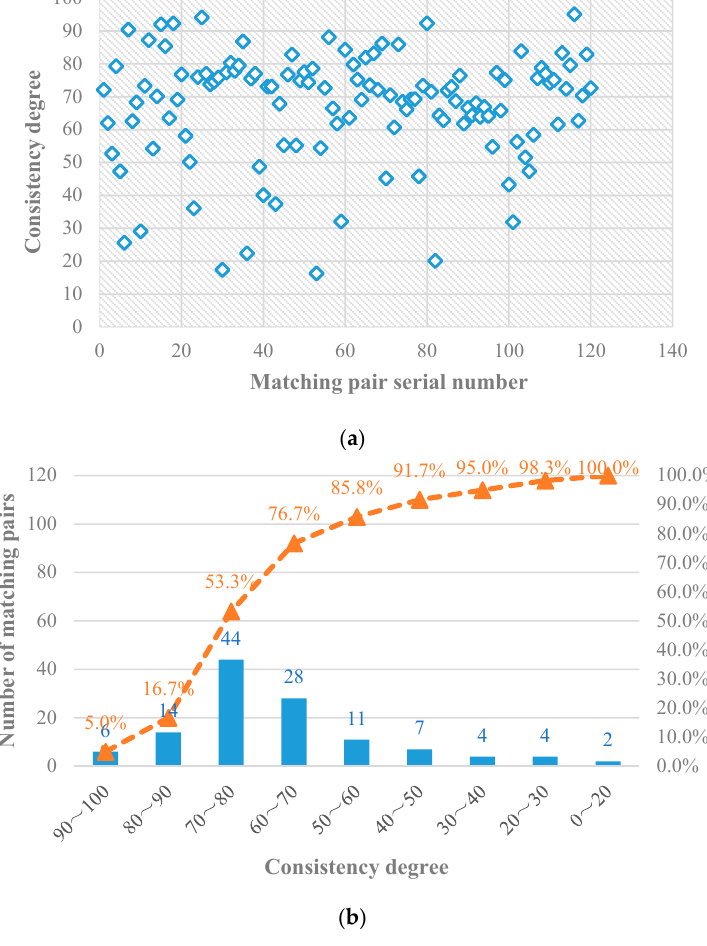
Figure 7. Computational ( a ) and statistical ( b ) results of the matching pairs’ consistency degree, where the orange dotted line represents the curve with the cumulative proportion of the number of matching pairs in different consistency degree intervals